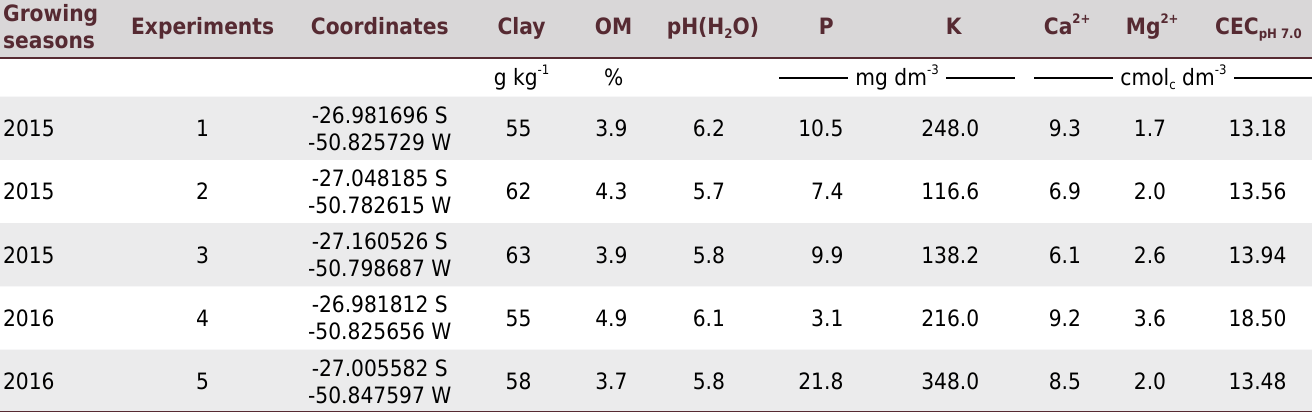
Table 1. Physical and chemical properties of soils used in the experiments with nitrogen doses in the 2015 and 2016 growing seasons Growing seasons